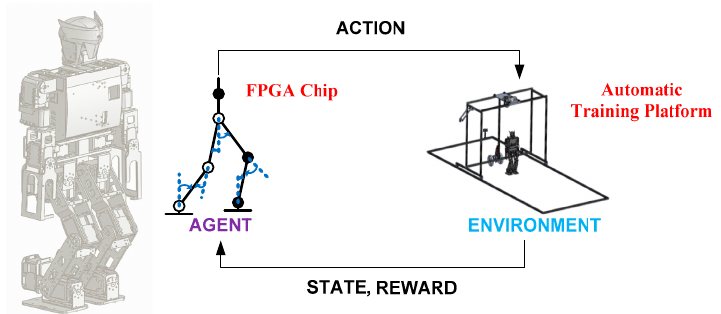
Figure 16. Proposed learning framework with Q-learning algorithm.